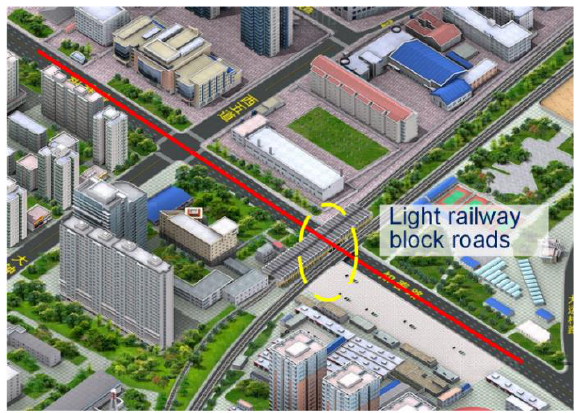
Figure 20. 3D map of roads blocked by a light railway.